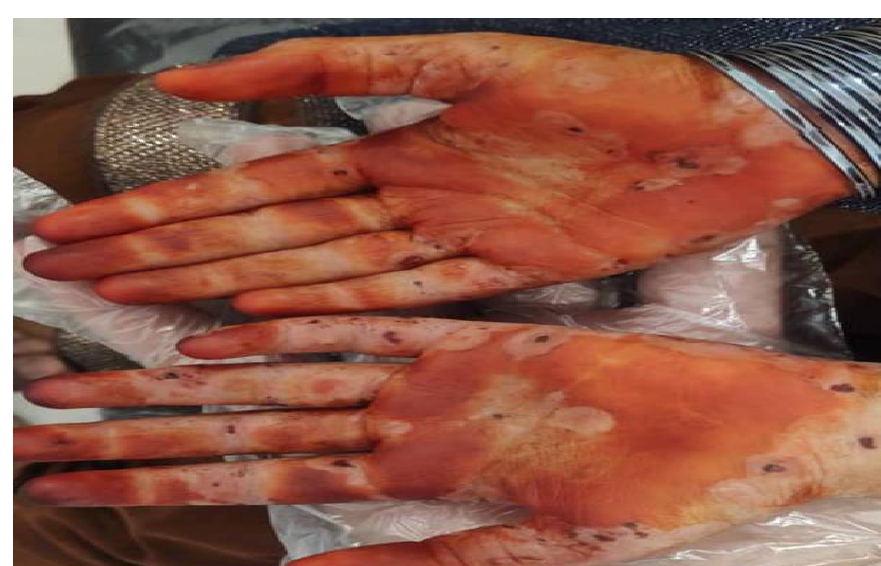
Figure 3. Trunk having grain-sized papules and depigmentation.